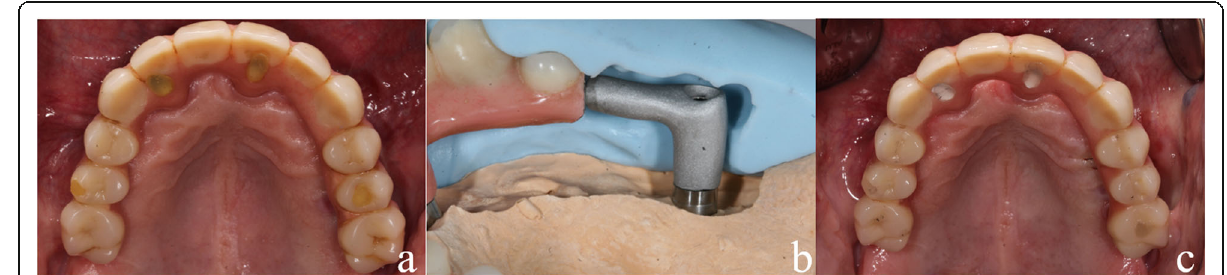
Fig. 3 a The restoration of the case in Fig. 2 before explantation. During the entire healing time of the dorsal implant in the 2nd quadrant, the restoration was fixed on the three osseointegrated implants and the one loosened implant in the 2nd quadrant. b After successful osseointegration of the dorsal implant in the 2nd quadrant, the dentures were adapted to the new situation. For this purpose, the dorsal element of the restoration in the 2nd quadrant, which was the connection to the loosened implant, was separated. A connection piece was cast on the